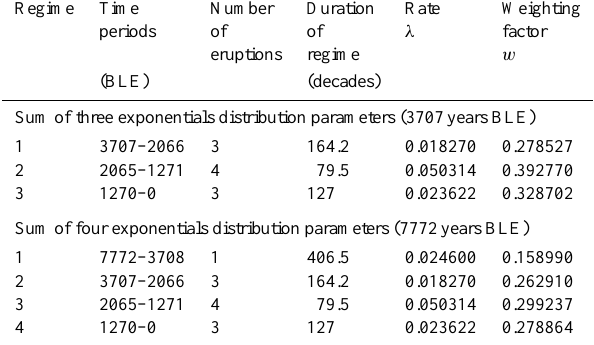
Table 4. Eruption rates λ Mvei for each VEI class. The slope- b of the loglinear relationships given by Eq. (1), and the regression coef- ficients for each model of El Chich´on volcano listed in the Table 2 for the period 3707years BLE are included in the lower rows.